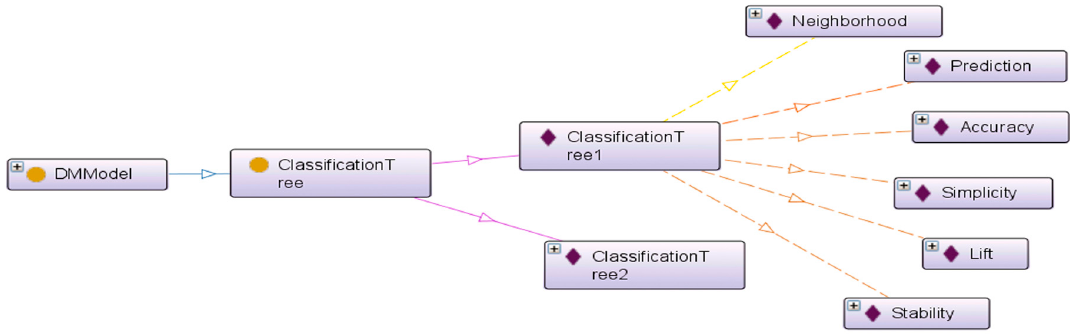
Figure 2. Onto graph representation of DMModel individuals and its object properties.